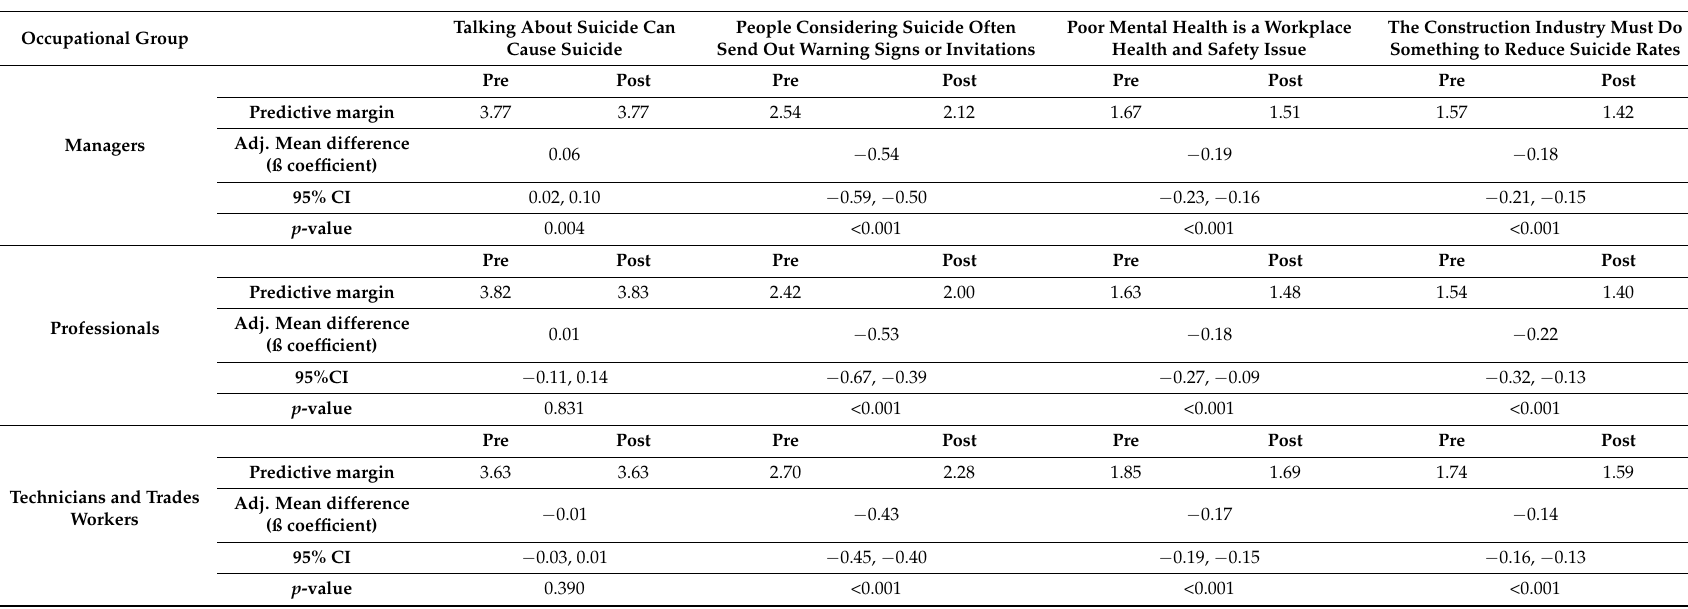
Table 4. Predictive margins for pre- and post-test beliefs, and mean differences in change in beliefs * for occupational groups